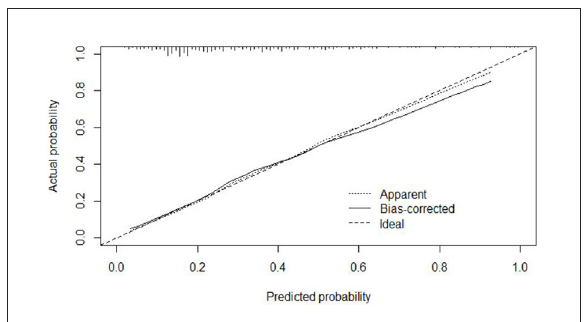
FIGURE9 DCA of internal verification set.